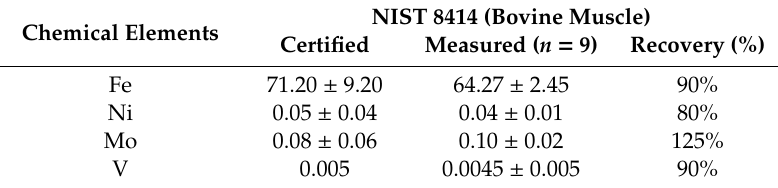
Table 1. Analysis of NIST (National Institute of Standards and Technology) 8414 Bovine